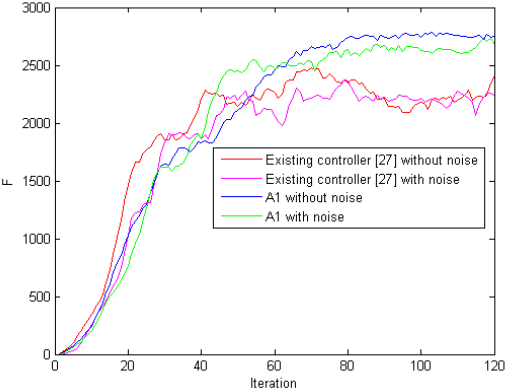
Figure 12. The F evolution of two methods without and with noise for coverage. The red and purple lines are for the controller without and with noise in Reference [27], respectively. The blue and green lines are for A1 without and with noise, respectively.